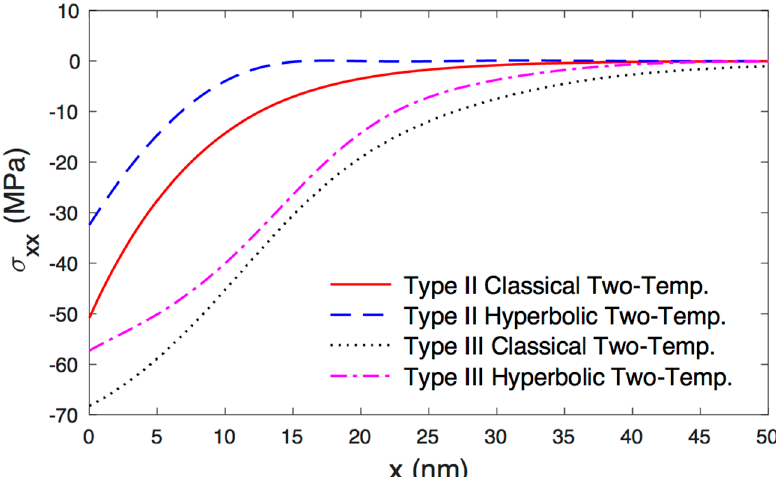
Figure 6. The variation of stress with respect the distance.